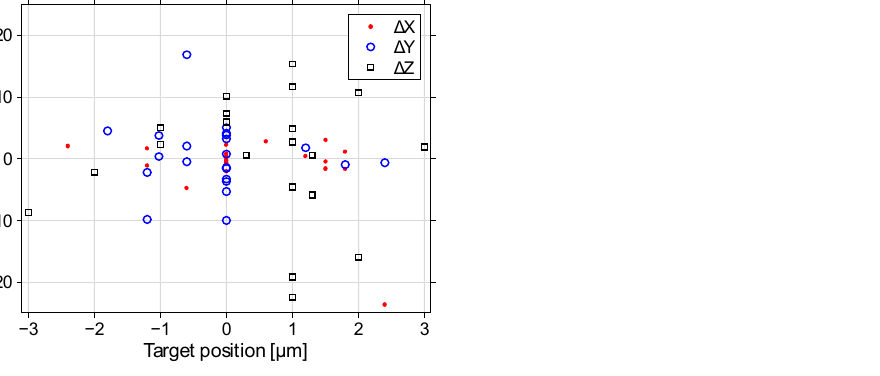
Figure 11. Position errors versus target position (𝑋,𝑌,𝑍) . Most individual positioning errors are within ±10 nm.